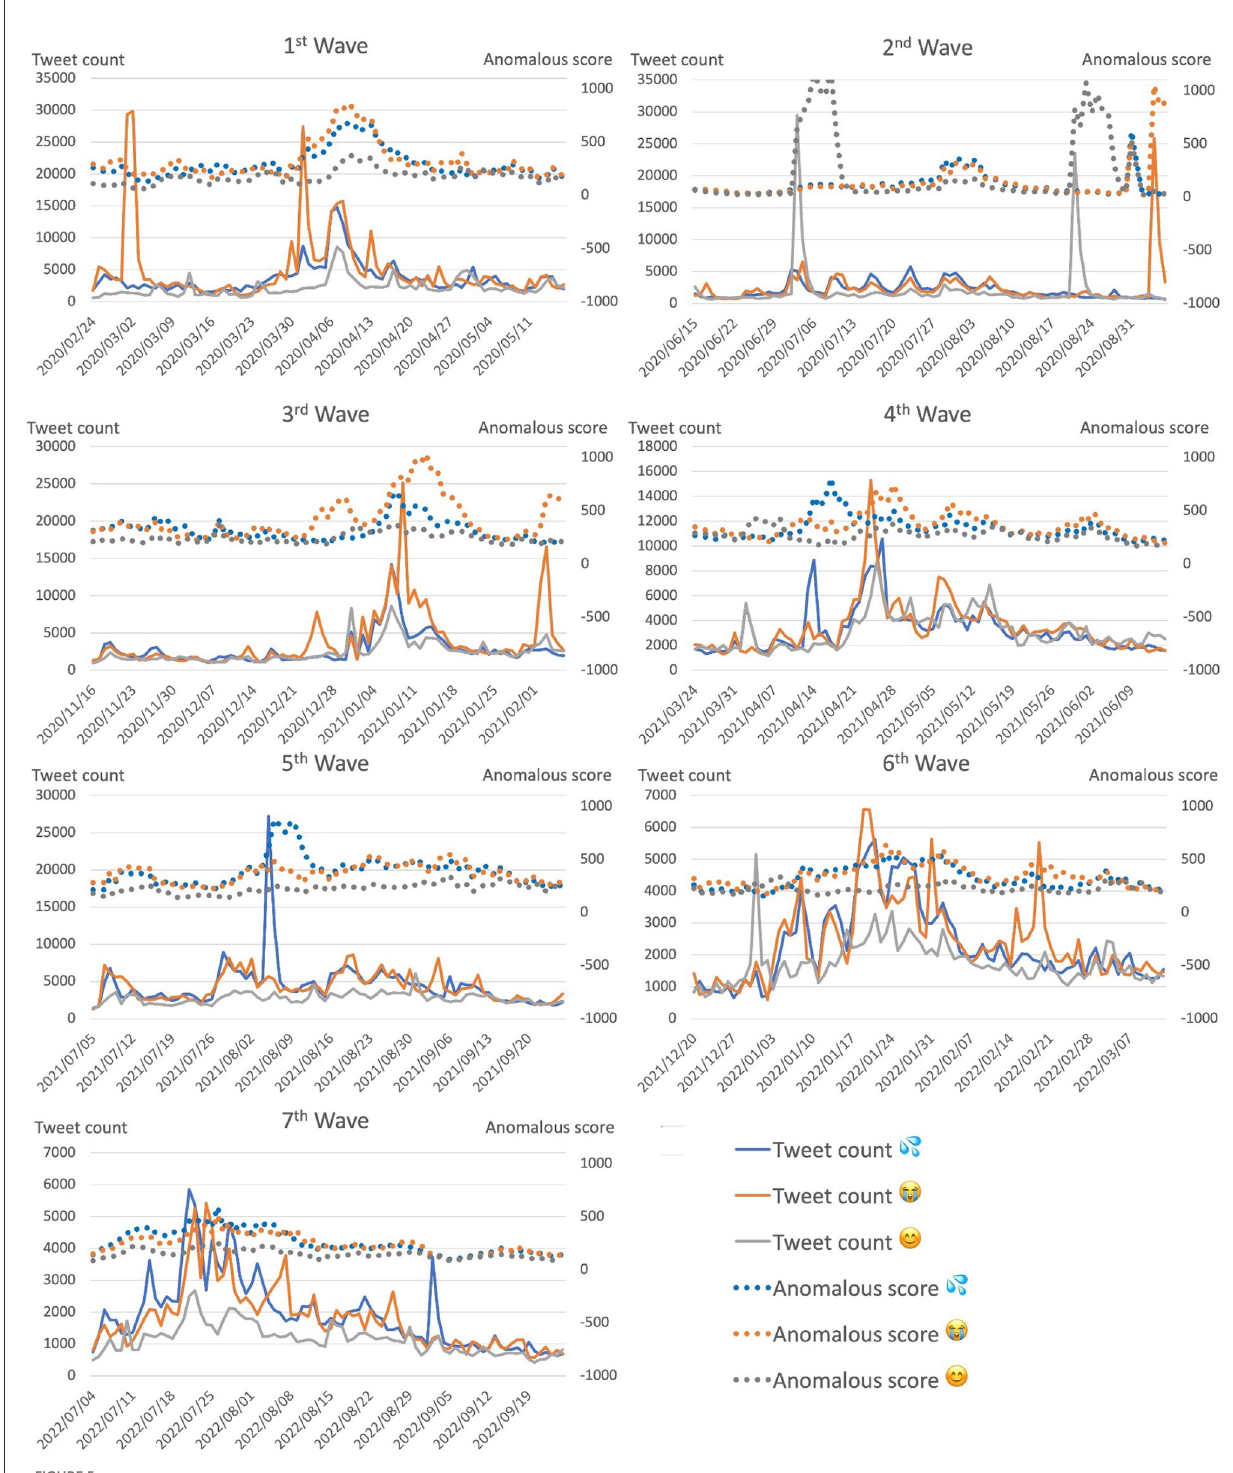
FIGURE5 Anomalous scores of top-3 used emoji with corresponding tweet counts for each COVID-19 wave over period of 12 weeks: 7 weeks before, 1 week during, and 4 weeks after peak of corresponding wave. Anomalous scores represent situations in which there were surges in social media reaction, which resulted in structural changes in social media